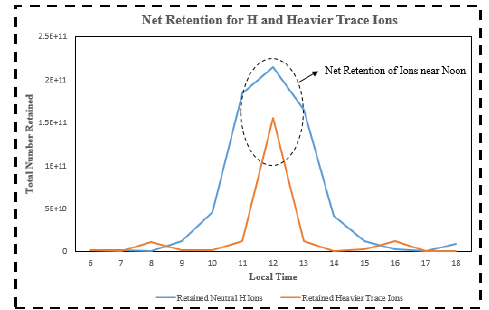
Figure 3. Comparison of H ions retained during ICME and that of the normal days. Figure 5. Total retained H and heavy trace ions as a function of T L . The retained number of heavy ions is multiplied by 15 in order to visualize with a comparatively higher proportion of H ions. There are no local minima at noon due to the large population of particles with high activation energy (~ > 1 eV).